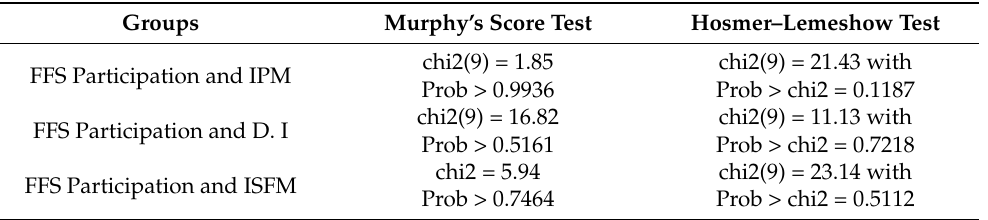
Table 3. Goodness of fit RBP